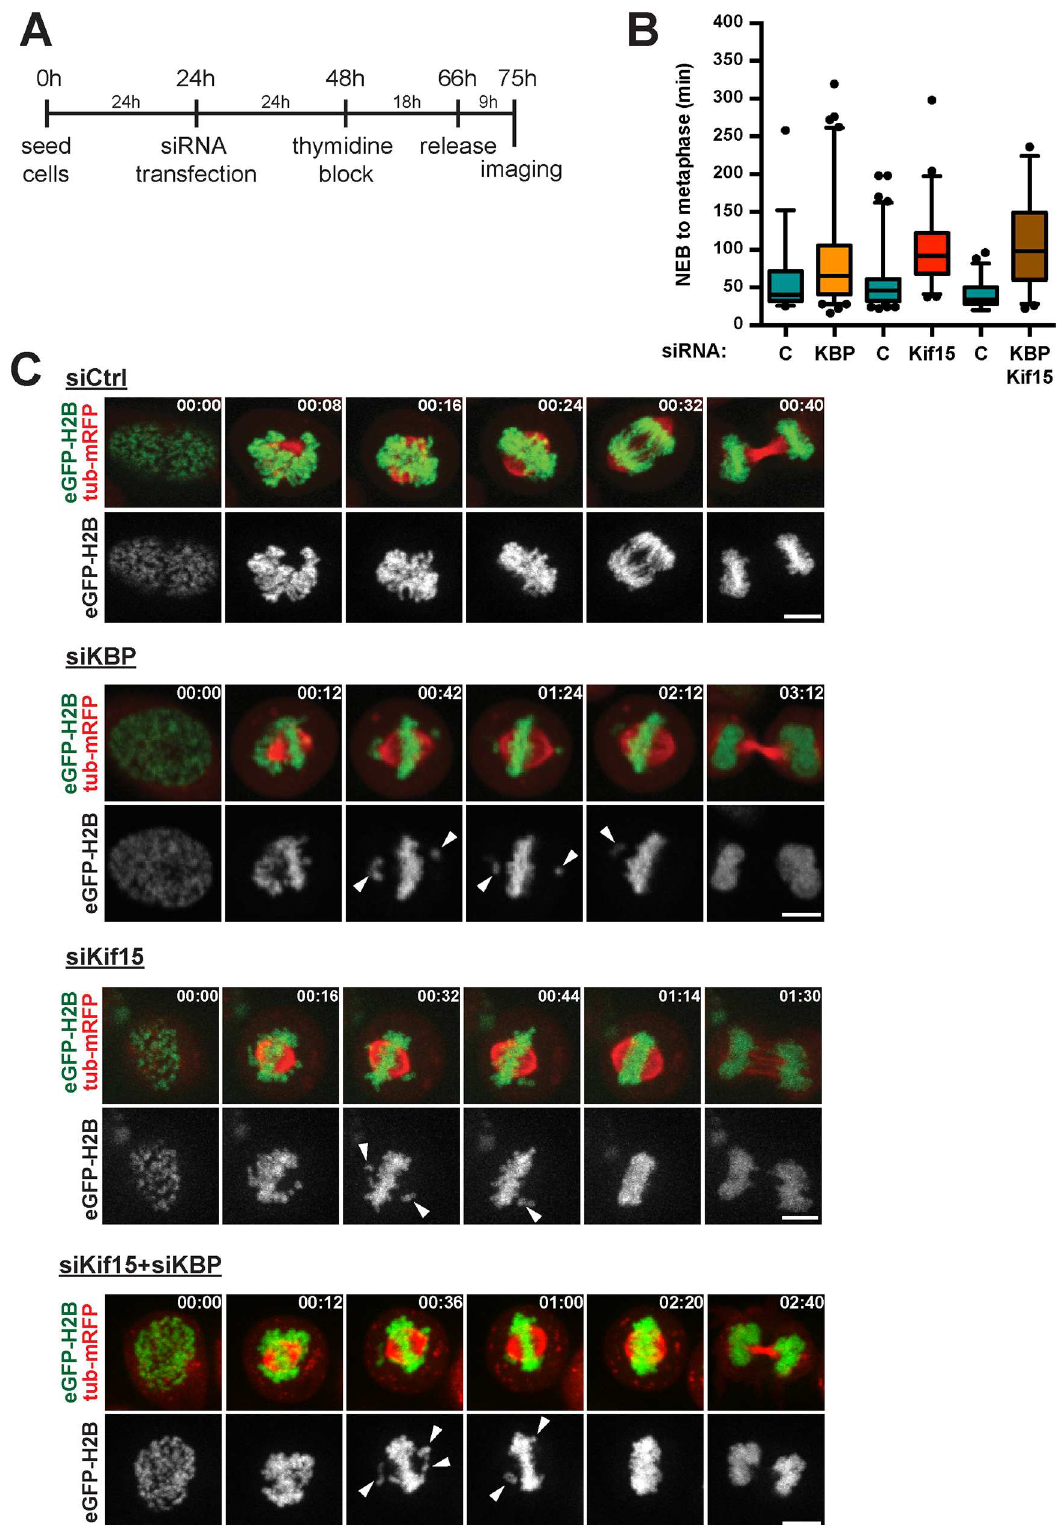
Fig 3. KBP and Kif15 function in efficient chromosome alignment. (A) Scheme outliningthe experimental set-up of the live-cellimaging. (B) Quantification of prometaphase durationas observed in the live-cellimagingin control (C), KBP-,